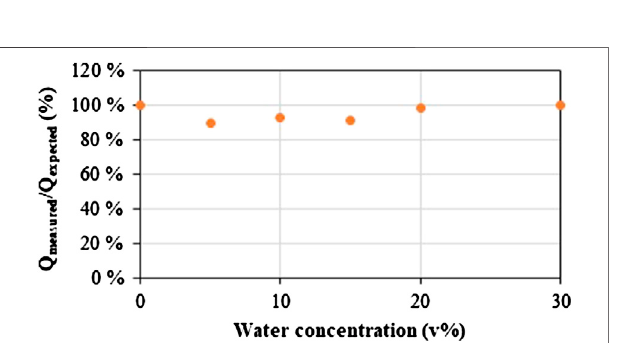
FIGURE6 | Adsorption capacitiesfor different desorption times at adesorption fl ow rate of10 Nl/min. Adsorption was performed at a fl ow rate of1 Nl/min (15 v% CO 2 , 85 v% air) during 100 s at 26 ° C. (A) Adsorption capacities for a desorption time in the range of 3 – 20 s. (B) Normalized breakthrough curve measured after a regeneration time of 3 s (green), 8 s (light blue) and 20 s (gray).